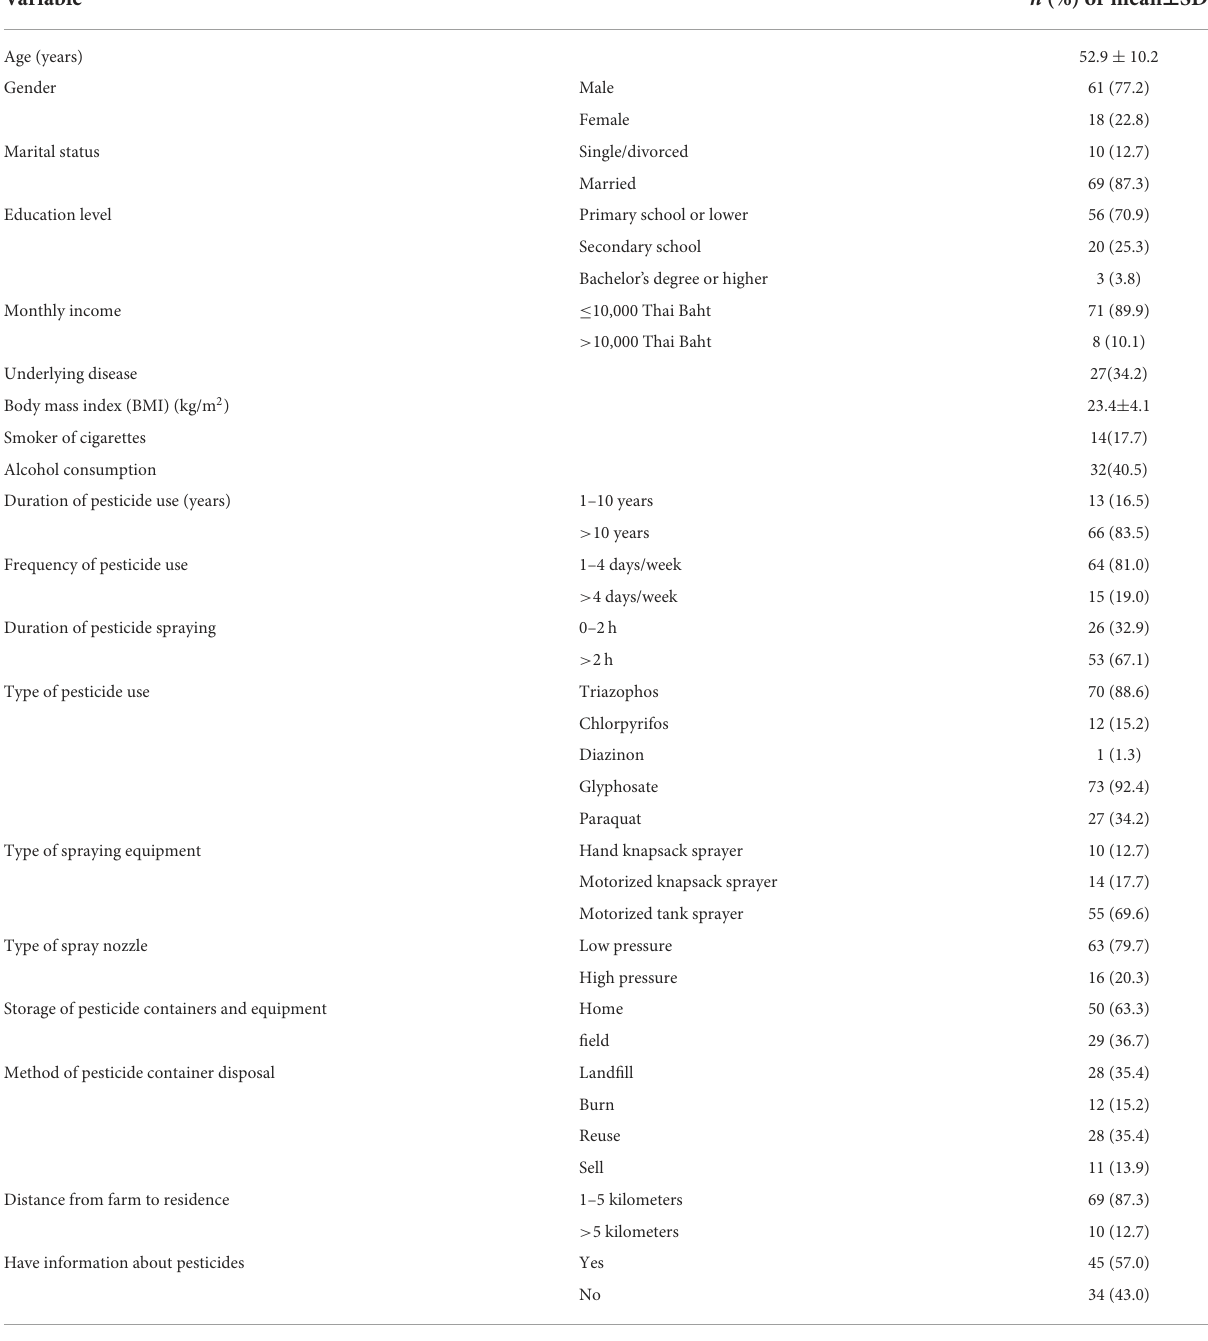
TABLE 1 Demographic characteristics and agricultural information of pesticide applicators ( n =